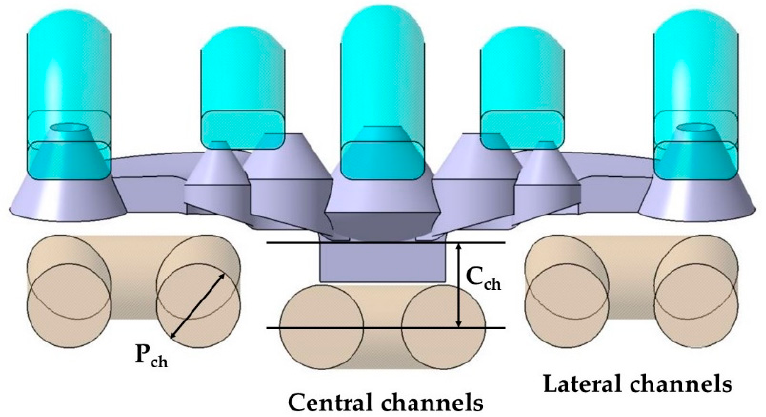
Figure 10. Design parameters P ch y C ch of the conformal refrigeration layout in the cavity plate.